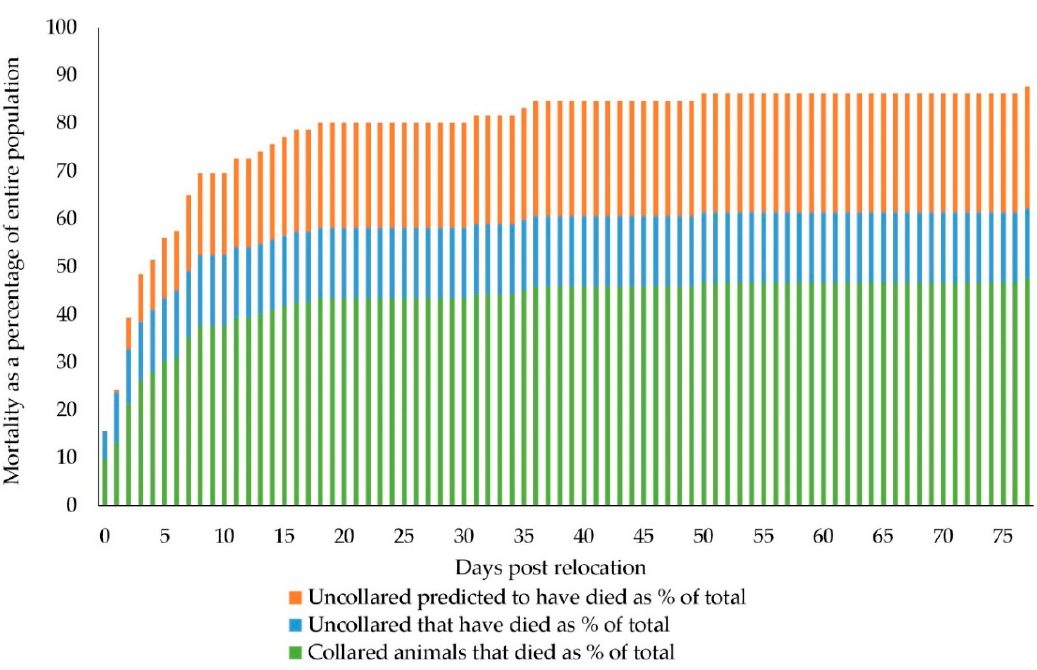
Figure 2. Mortality rate of western grey kangaroos as a percentage of the total number relocated.